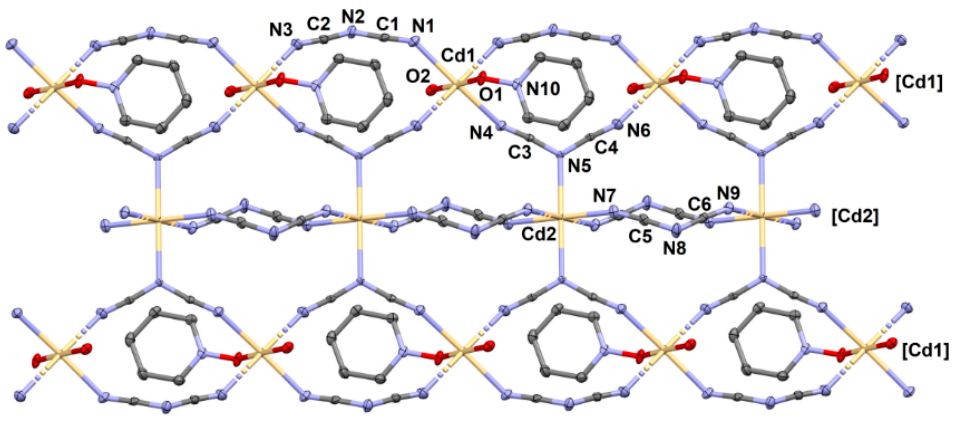
Figure 2. Ribbons consisting of three 1D chains in complex 2 . (Color code: yellow, Cd; red, O; blue, N; black, C.)